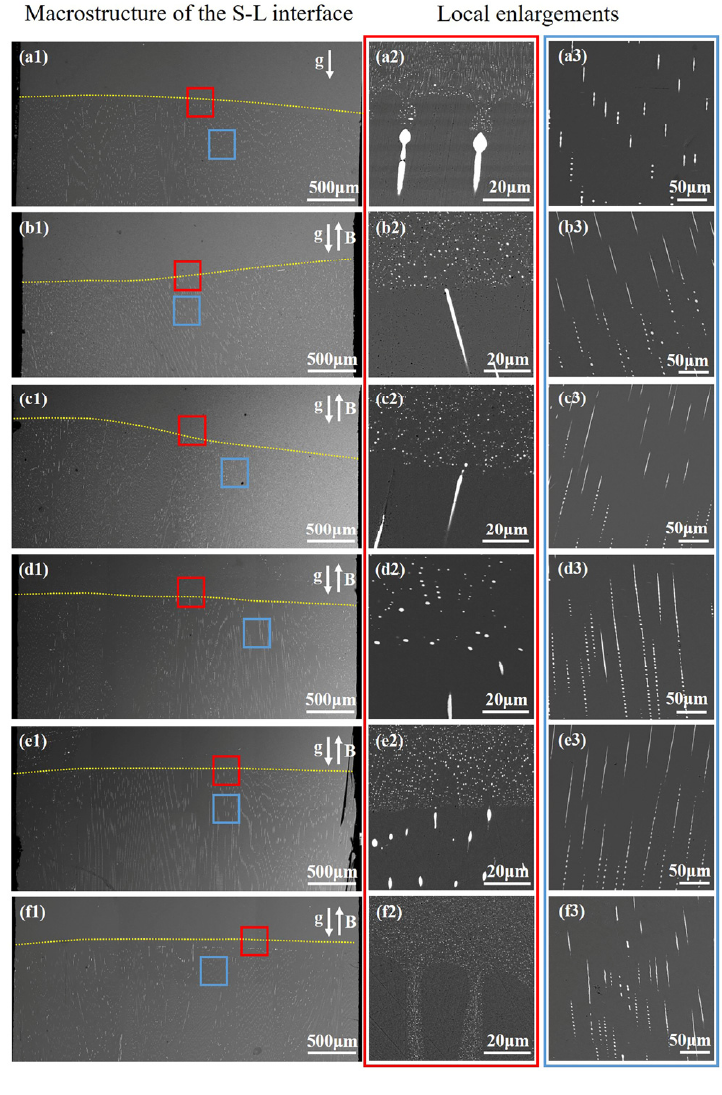
Figure 2. The morphology of the S-L interfaces and microstructures of ingots directionally solidified at a growth rate of 5 μ m/s under various MFDs. ( a1 – a3 ) 0 T; ( b1 – b3 ) 0.1 T; ( c1 – c3 ) 0.5 T; ( d1 – d3 ) 1 T; ( e1 – e3 ) 3 T; ( f1 – f3 ) 5 T. The yellow dotted lines are used to show the S-L interfaces.